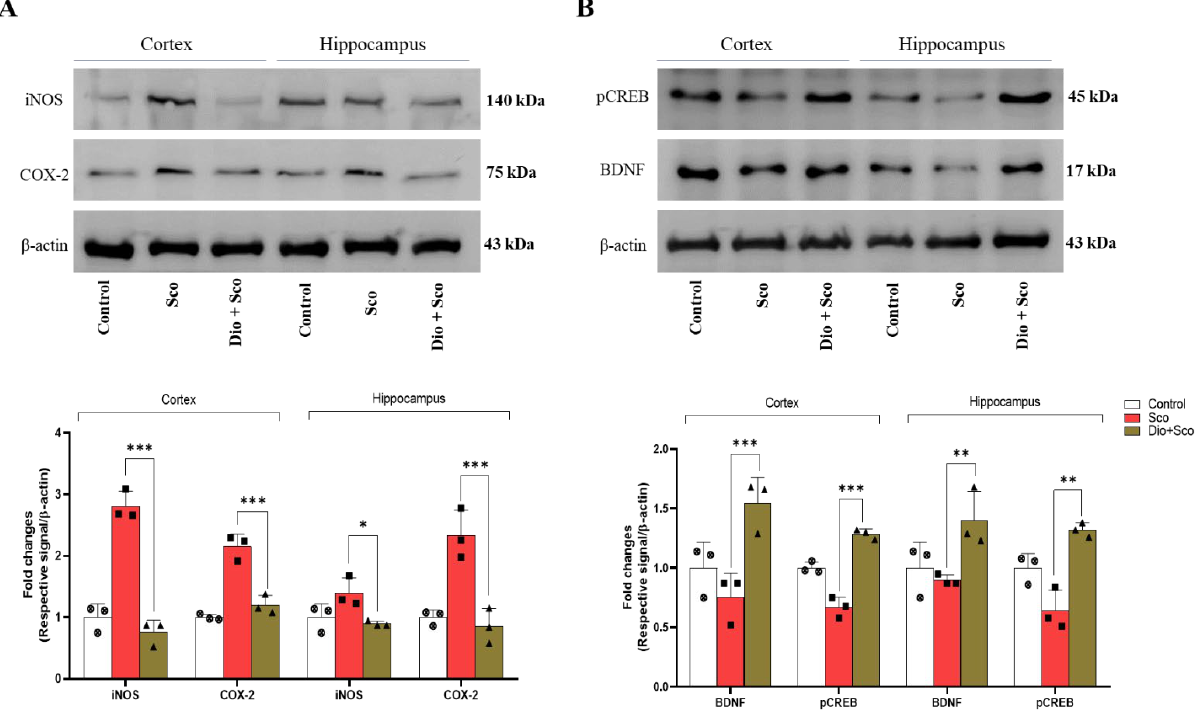
Figure 6. Dioscin effect on scopolamine-stimulated inflammatory response. ( A ) Dioscin treatment and pro-inflammatory response in cerebral cortex and hippocampus, and ( B ) neurotrophic factors. Sco, Scopolamine; Dio, Dioscin; each shape (circles, triangles, squares, etc.) is representative of the number of repetitions of a particular group; * p < 0.05, ** p < 0.01, and *** p < 0.001 comparing scopolamine vs. dioscin +